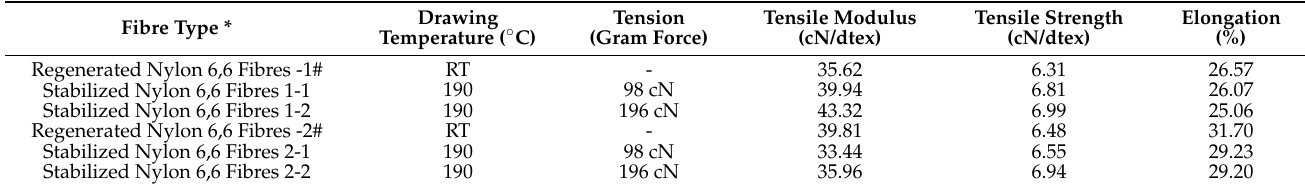
Table 4. Mechanical Properties of Salt-confined and Reverted Nylon 6,6 Fibres.